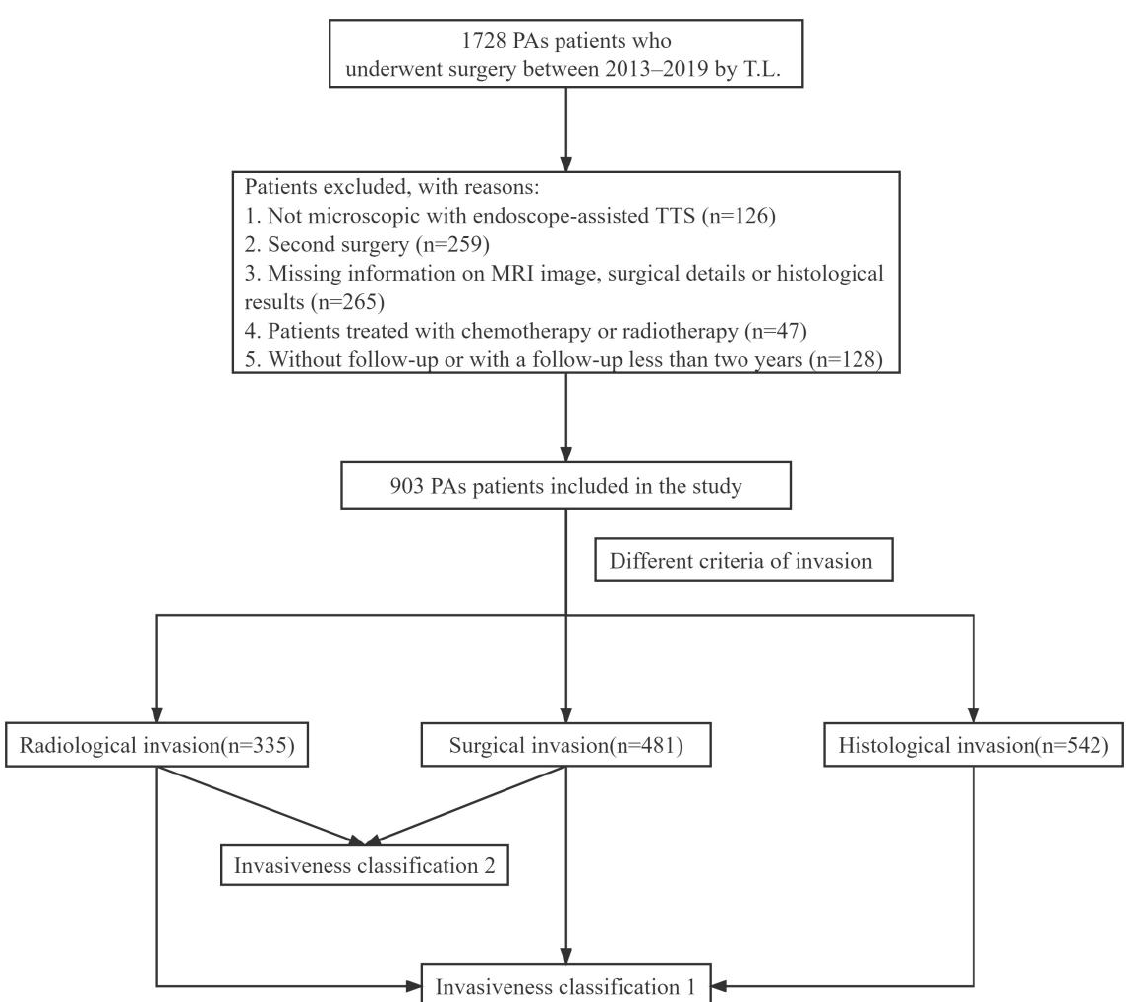
Figure 1. Flowchart summarizing the enrollment strategy and design of the study. PAs: Pituitary Adenomas; TTS: Transnasal-Transsphenoidal Surgery.